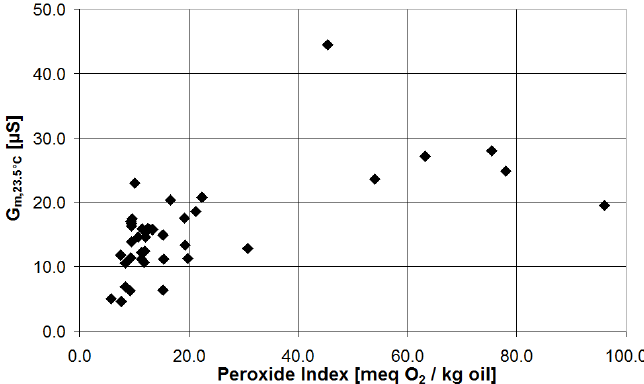
Figure 9. Emulsion electrical conductance at 23.5 °C using the DW reagent as function of peroxide index for the full set of 40 olive oil samples.